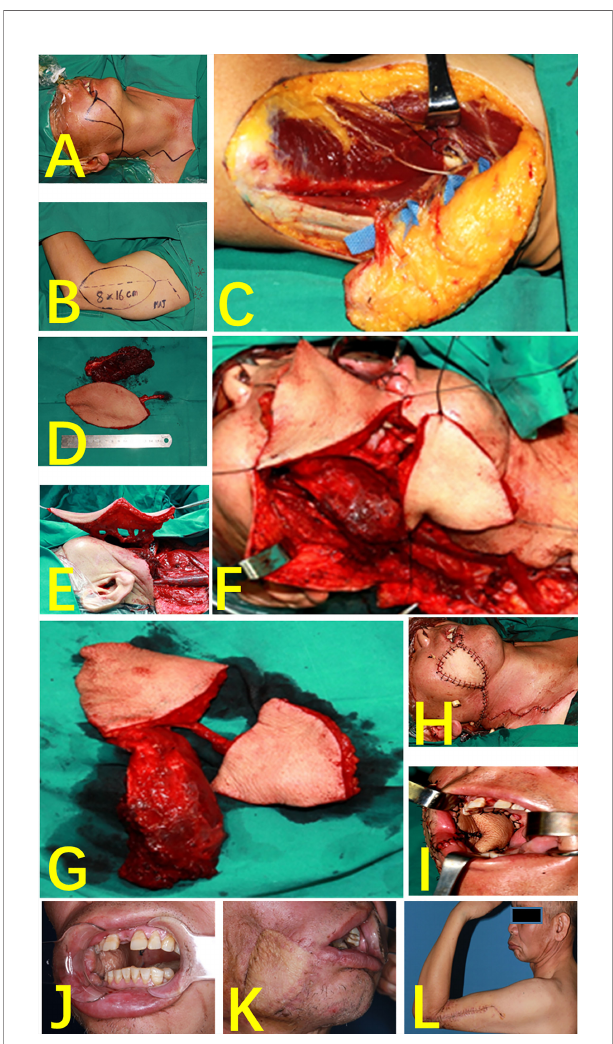
FIGURE 5 | Case 2 (multi-lobed + chimeric combined fl ap). (A) Perforated resection of right buccal carcinoma. (B) Flap design. (C) Three cutaneous perforators and one muscle perforator were found during the operation. (D) Chimeric fl ap. (E) Vascular anastomosis. (F) The multi-lobed fl ap was designed according to the area of the defect size of inside and outside the mouth. (G) Multi-lobed + chimeric combined fl ap. (H) Repair of cheek defects. (I) Repair of buccal mucosa defects. (J) Skin island of the fl ap intraorally, 1 month postoperatively. (K) One month after surgery, right facial fl ap. (L) Elbow bending, 1 month after